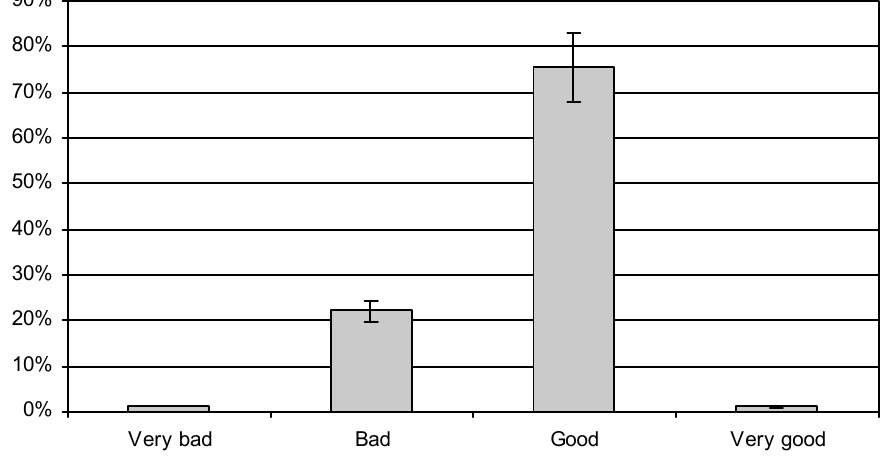
Figure 9. Participants own assessment of diet quality.